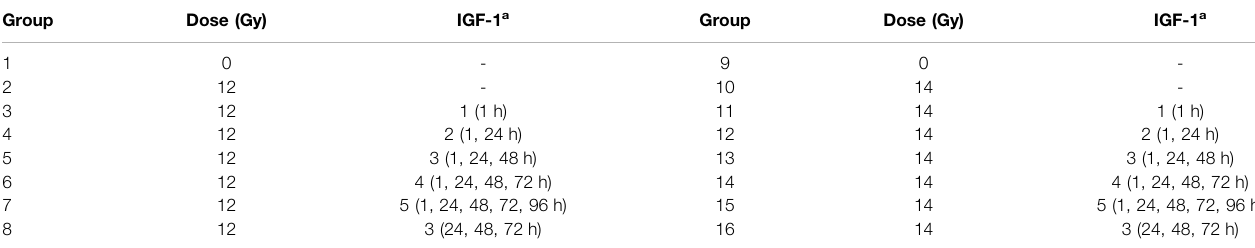
TABLE 1 | The experimental setup used to evaluate the different IGF-1 dosage regimens on the mitigation of ionizing radiation-induced gastrointestinal damage and peripheral blood changes. Group Dose